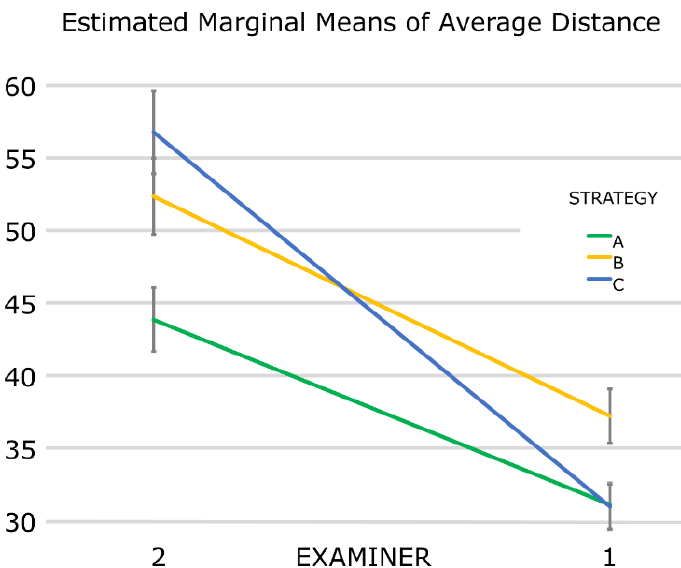
Figure 3. Comparison of the achieved trueness between the examiners for each scanning strategy. Error bars: 95% confidence interval. Values in μm.